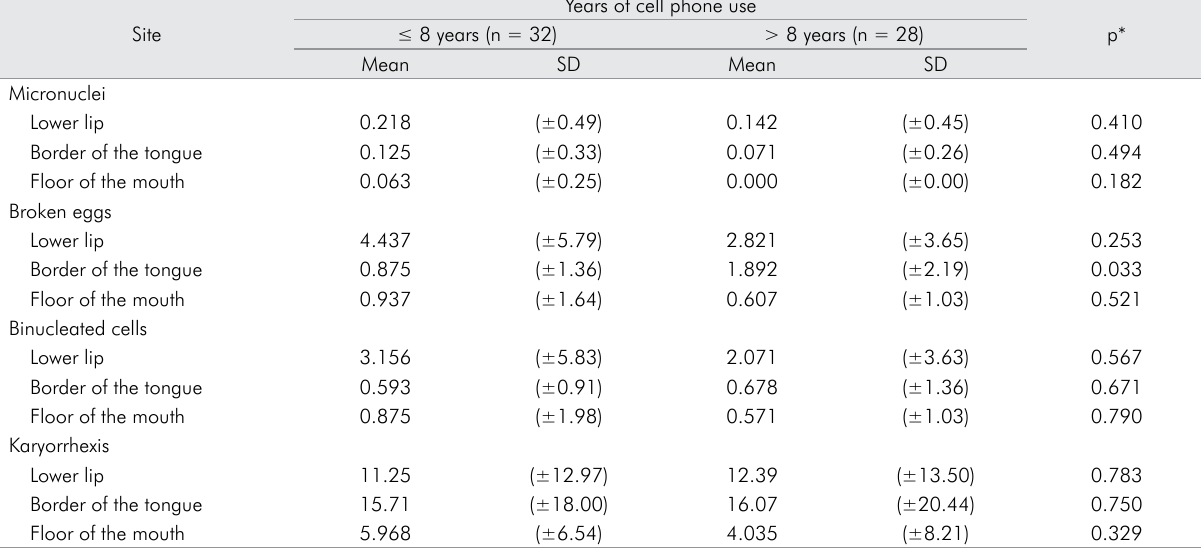
Table 3. Comparison of years of cell phone use and mean values of nuclear changes at each anatomical site (1,000 cells).